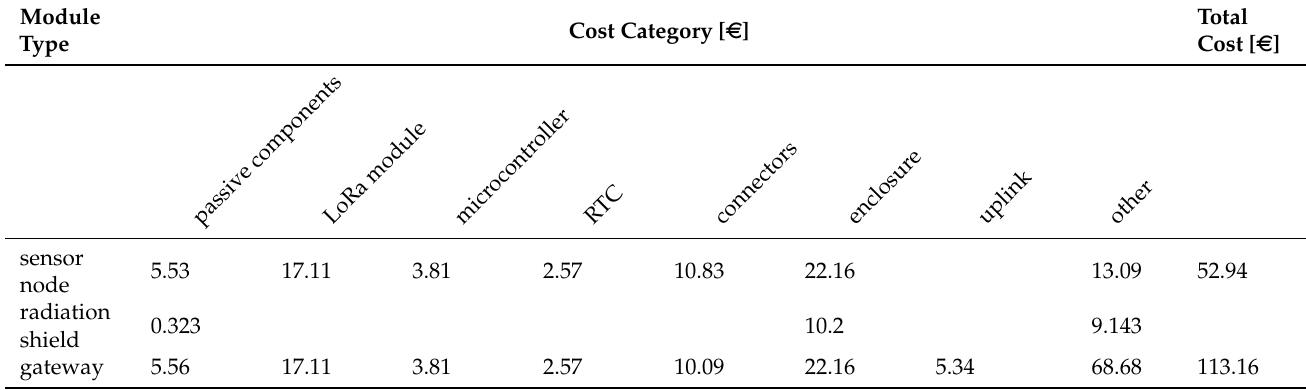
Table 5. Cost-calculation of MIRRA hardware. The other category includes all remaining components not covered by the other columns, including integrated circuit and passive components, connectors, and batteries. Module